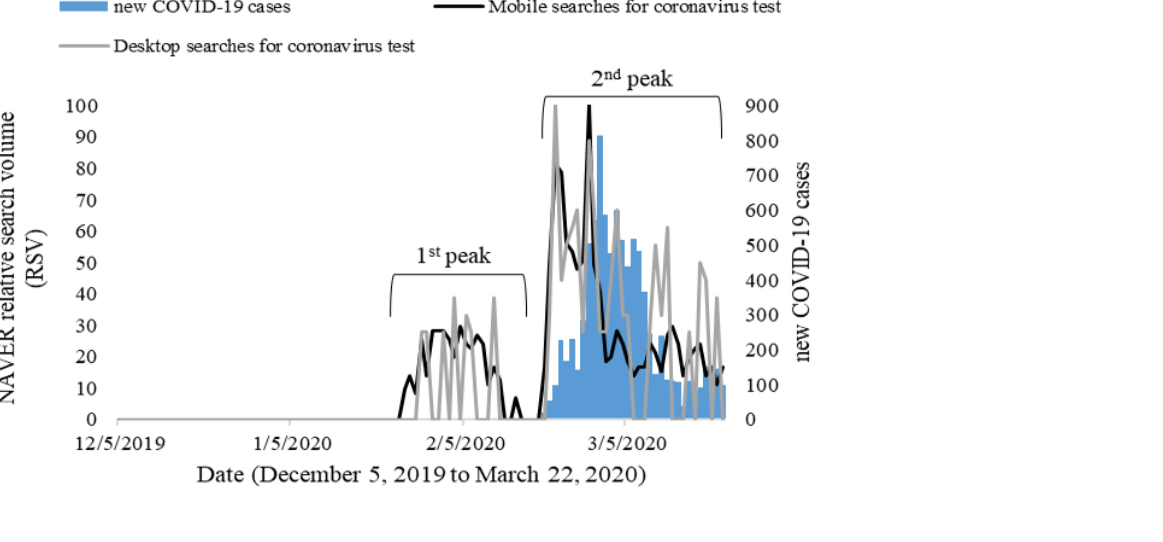
Spearman rank correlation coefficients in Table 3 demonstrated strong correlations for the overall data set (mobile and desktop searches) of coronavirus searches with a lag of 3 days ( r =0.729), as well as mobile searches ( r =0.761). Interestingly, mobile searches had stronger correlation coefficients for all lag and lead periods than did overall searches. However, weak to moderate correlations ( r =0.417-0.546) were observed for